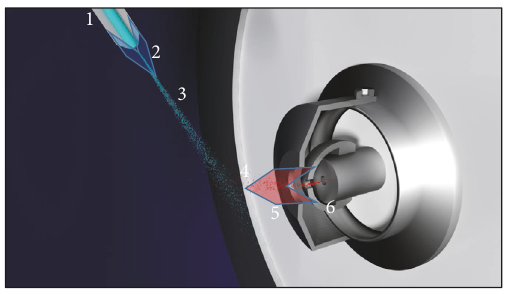
Figure 1: Schematic drawing of the ESI source in front of the MS inlet. 1, sprayer; 2, nebulizer gas (blue arrow); 3, spray/plume; 4, ions (red dots); 5, dry gas (red arrow); 6, MS inlet.